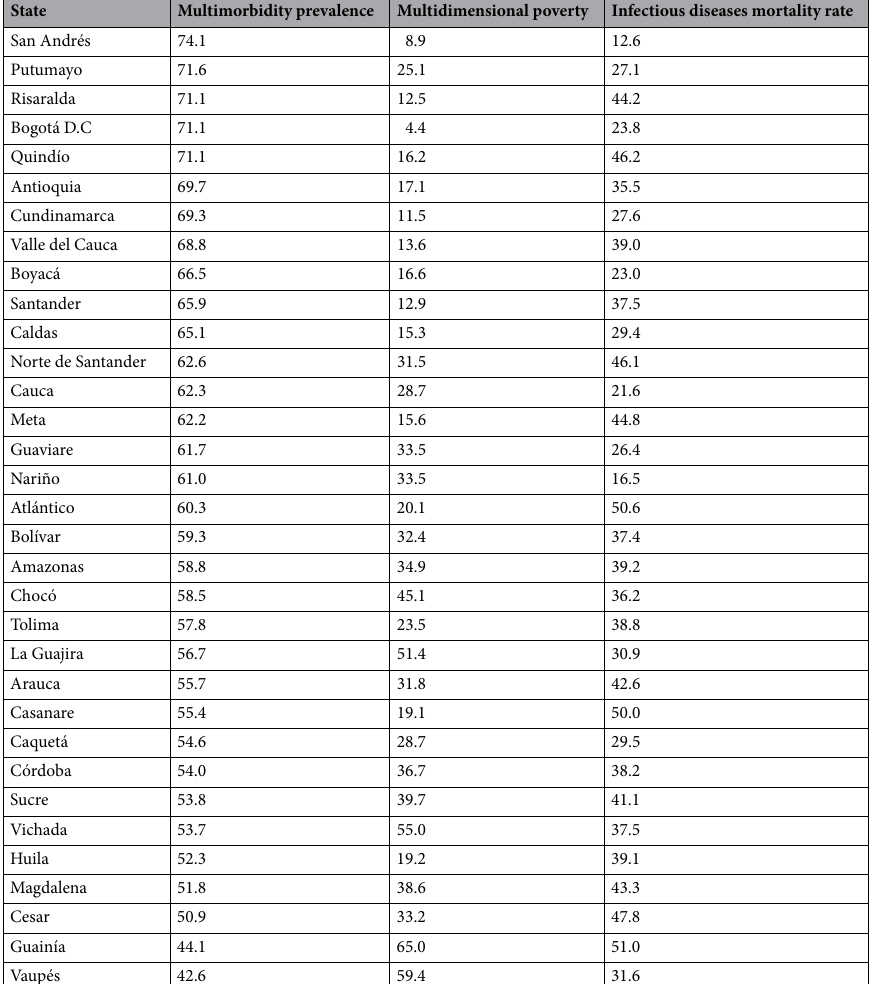
Table 4. Multimorbidity prevalence by state and state-level